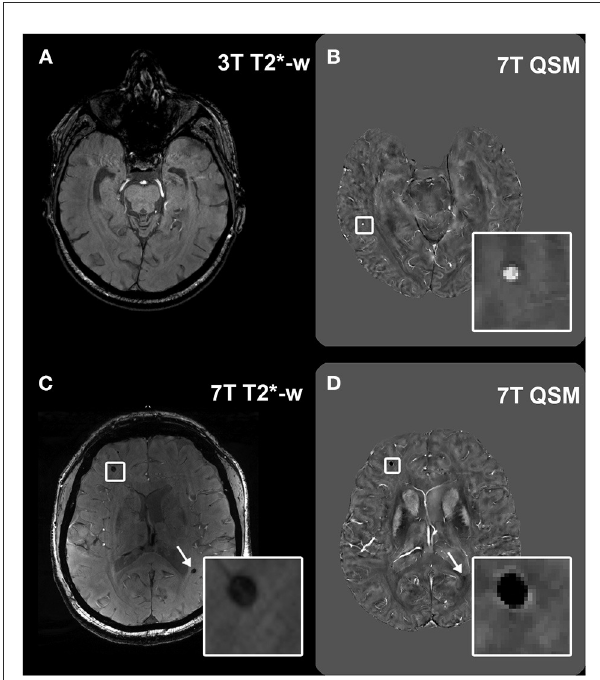
FIGURE5 Visualization of lesions at 7T QSM. Legend: Example of a microbleed (MB) which was not visible at 3T T2*-w imaging in a healthy control (A) , but was then detected at 7T QSM [ (B) , inset]. Calcifications can appear as hypointense round structures on T2*-w imaging, easily mimicking MBs [ (C) , inset and arrow], however they can be differentiated from MBs in the QSM because of their hypointense appearance [ (D) , inset and